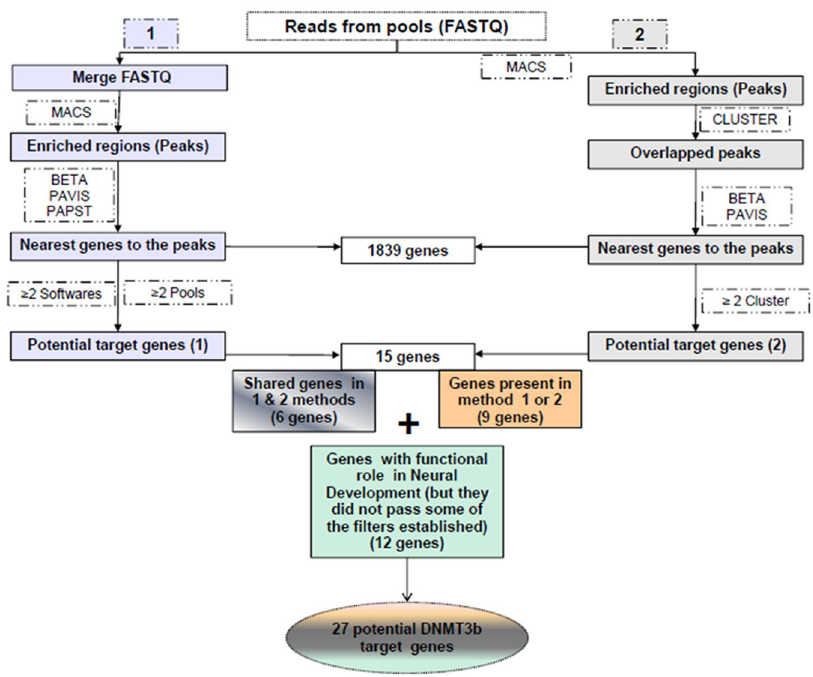
Figure 1. Prioritization and selection of DNMT3b-targets. Diagram showing both methodological approaches used for the selection of DNMT3b target